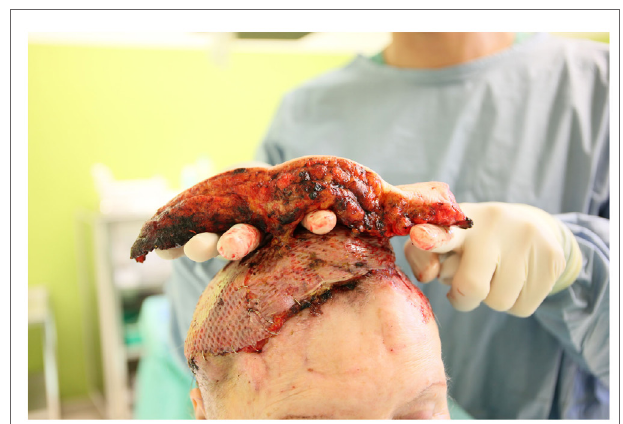
FiGURe 4 | Skin paddle of a latissimus dorsi free flap based on three perforator vessels 1 week after surgery